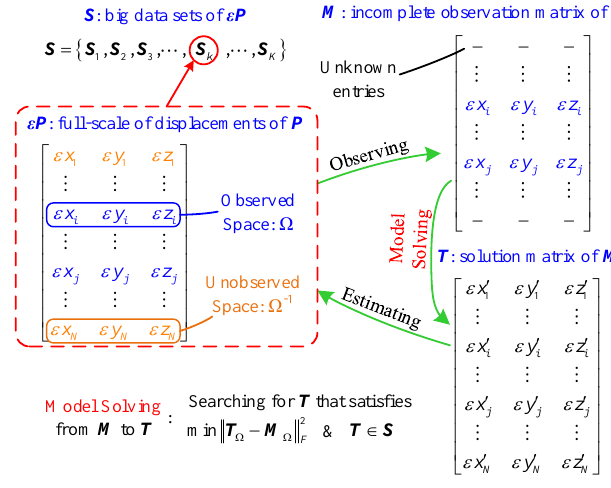
Figure 3. Principle of model solution.